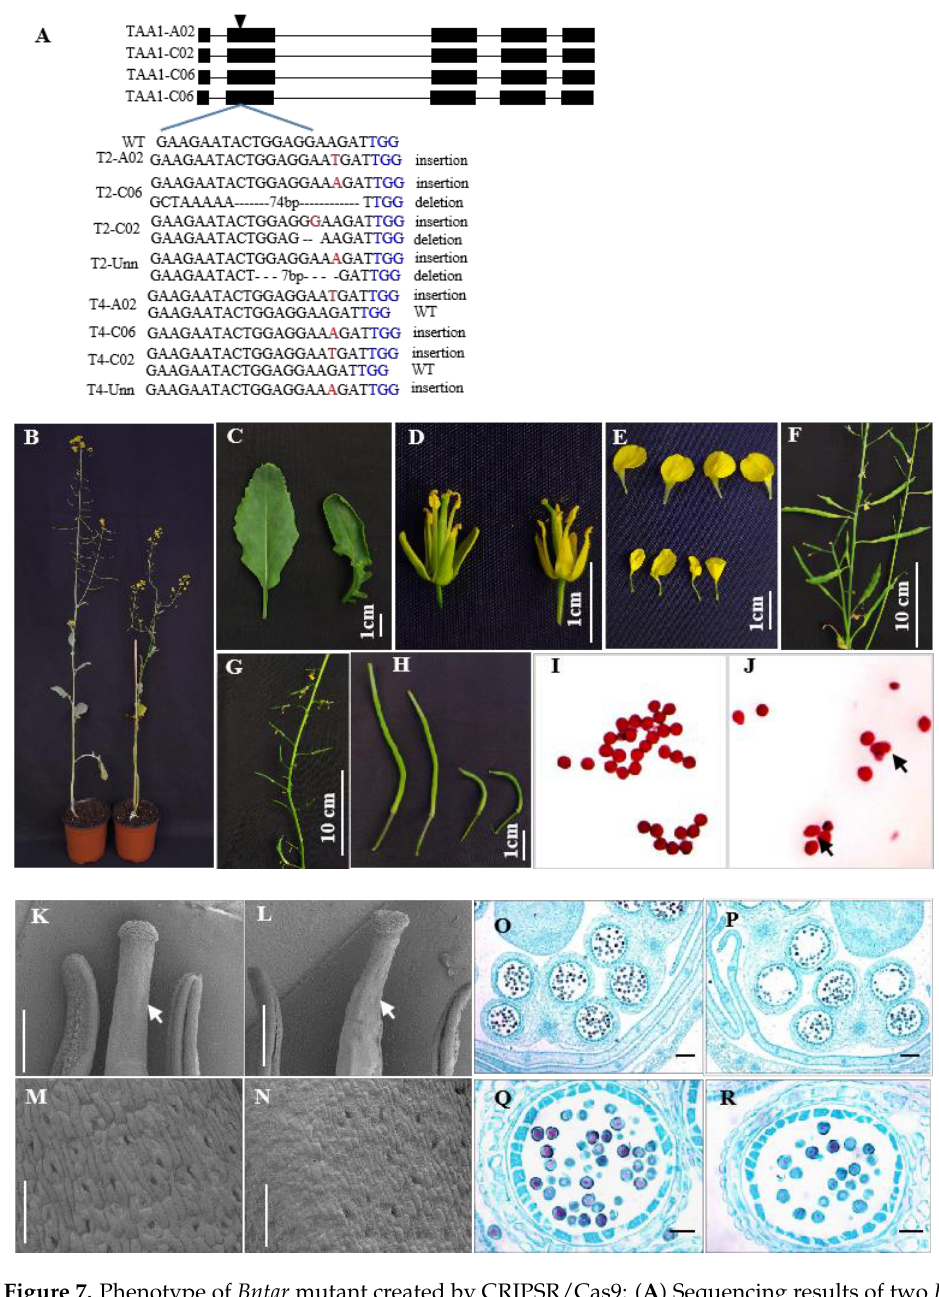
Figure 7. Phenotype of Bntar mutant created by CRIPSR/Cas9: ( A ) Sequencing results of two Bntar mutants. Letters in black and blue indicate target sequences and PAM; red color and hyphen in the target sequences indicate insertions and deletions, respectively. ( B ) Phenotype of Bntar mutant (right side) and wild type (left side). ( C ) Leaf shape of Bntar mutant (right side) and wild type (left side). ( D ) Flower bud of Bntar mutant (right side) and wild type (left side). ( E ) Petal shape of Bntar mutant (upper side) and wild type (lower side). ( F ) Wild type and ( G ) Bntar mutant, showing images of silique shapes in main inflorescence. ( H ) Enlarged picture of pod at 10 days after flowering; wild type (left side) and Bntar mutant (right side). ( I , J ) Pollen stained by Alexander stain solution: wild type ( I ) and Bntar ( J ), arrows indicate enlarged pollen. Scanning electron microscopy image of wild-type ( K ) and Bntar ( L ) pistils and stamens. Arrows indicate shrinking sigma. Enlarged images of stigma of wild type ( M ) and Bntar ( N ). ( O – R ) Cross-sections of flower buds of wild type ( O , Q ) and Bntar ( P , R ). ( Q , R ) Images enlarged by one microsporangium. Bar = 2 μ m ( E , F ) and Bar = 10 μ m ( G , H ).